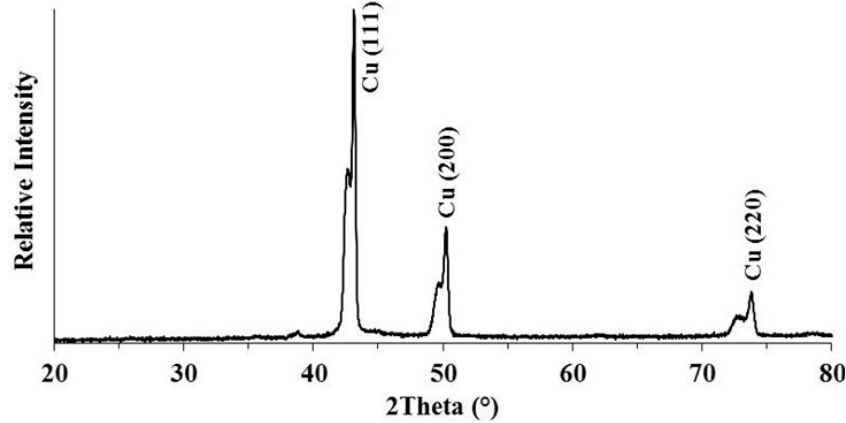
Figure 2. XRD spectrum of the Cu–10Sn powders. Table 1. Cold spray parameters for Cu-10Sn coating deposition. Spray Parameters